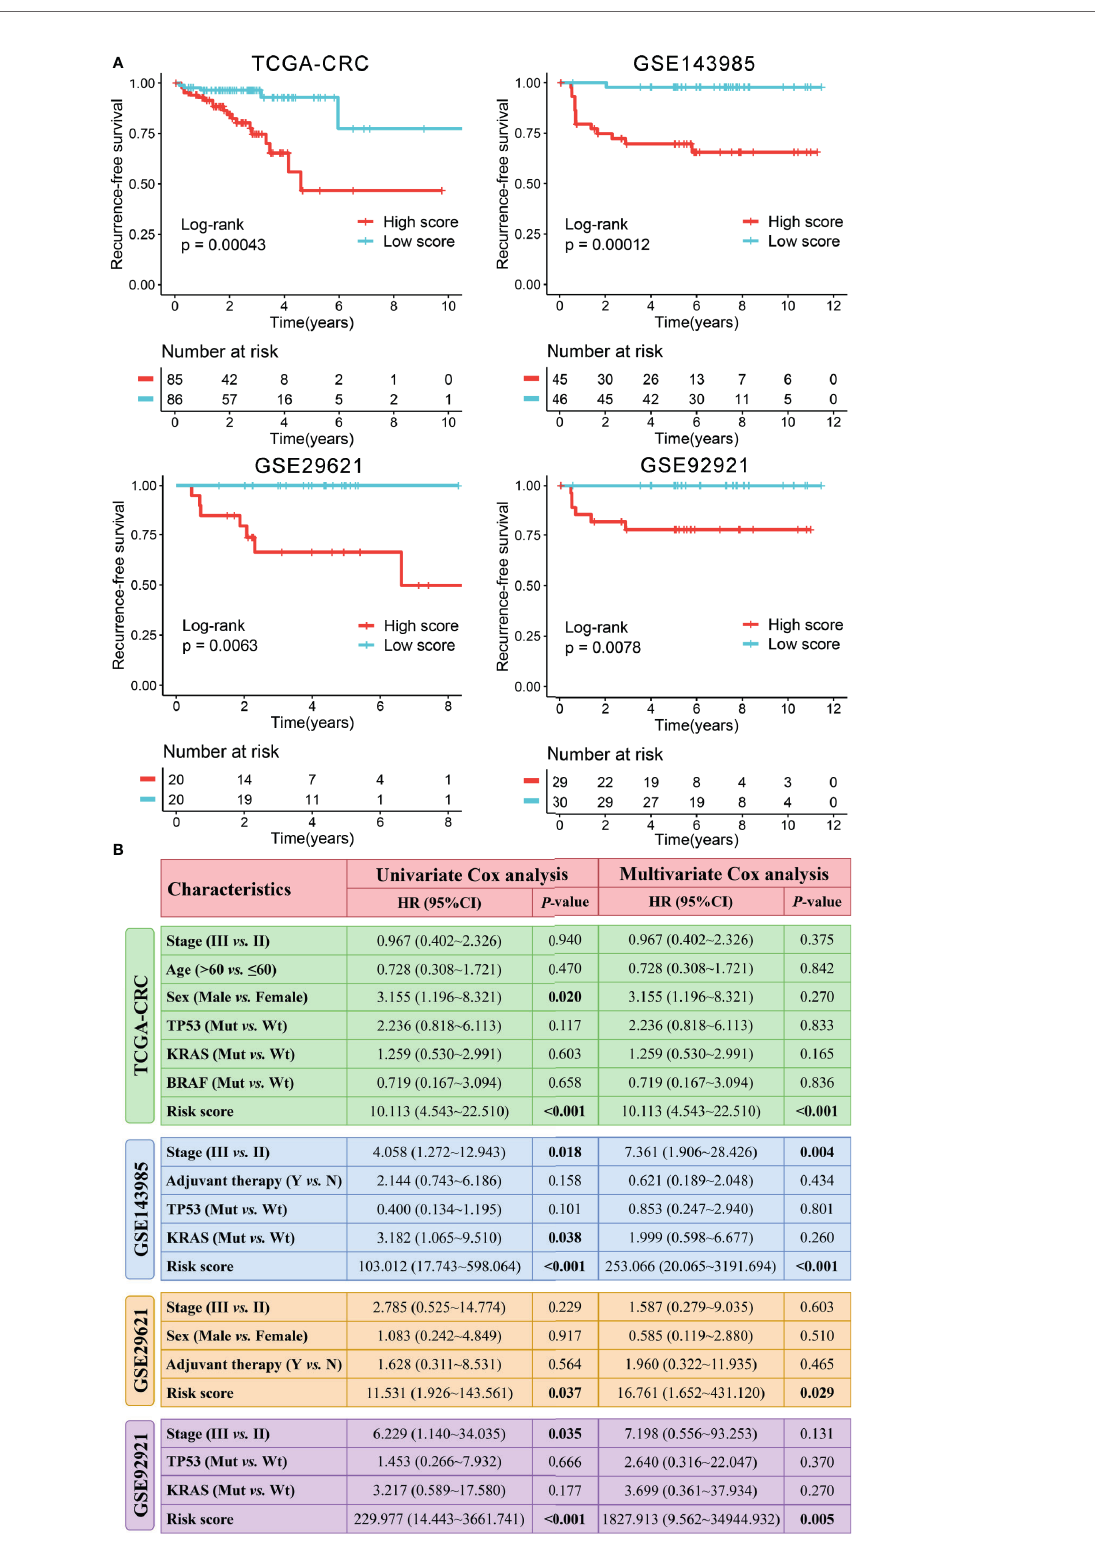
FIGURE 3 | Survival signi fi cance of RAIS in four cohorts. (A) Kaplan-Meier curves of RFS according to the RAIS. (B) Univariate and multivariate Cox regression analysis of the risk score. The bold values mean P